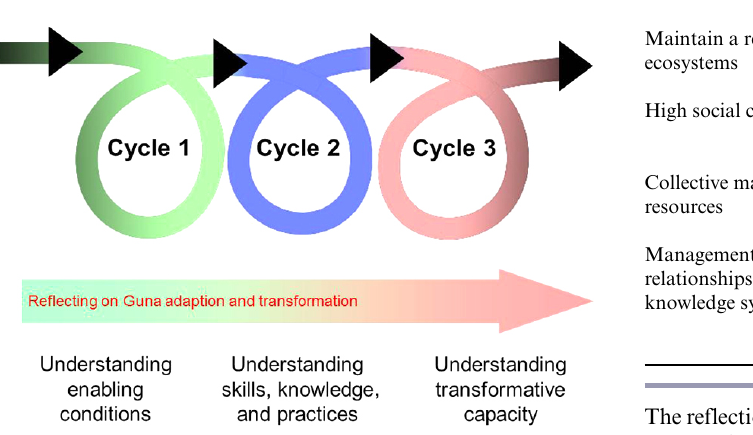
Fig. 1 . Three cycles of reflection that guided the participatory action research process.